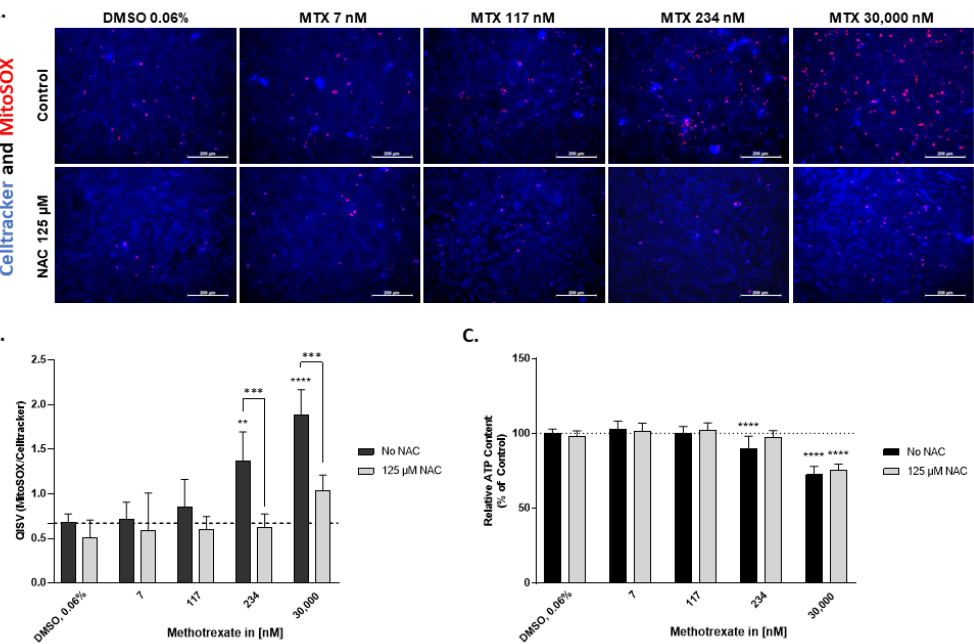
Figure 3. NAC treatment reduces superoxide formation in MTX-treated HepaRG. HepaRG were pre-exposed for 2 h to 125 µM NAC or left untreated, then exposed to MTX without NAC or MTX with NAC for 72 h. The HepaRG were stained live with Celltracker violet BMQC (blue) and MitoSOX TM (red) to investigate superoxide production following MTX exposure with and without NAC. Images were taken using the Zeiss Colibri 7 LED Fluorescence system ( A ). Scale bar representing 200 µm. The quantity of the MitoSOX TM was measured using ImageJ and normalized to the quantity of Celltracker violet BMQC. Data are expressed as QISV, N = 3 ( B ). Viability was assessed using the CellTiter-Glo ® Luminescent Cell Viability Assay and expressed as relative ATP content (% of control), N = 3 ( C ). For better illustration, dashed lines have been added showing the mean value of the solvent control DMSO, 0.06% ( B , C ). Bar graphs represent means ± SD; statistical analysis based on two-way ANOVA; **, p ≤ 0.01; ***, p ≤ 0.001; ****, p ≤ 0.0001.